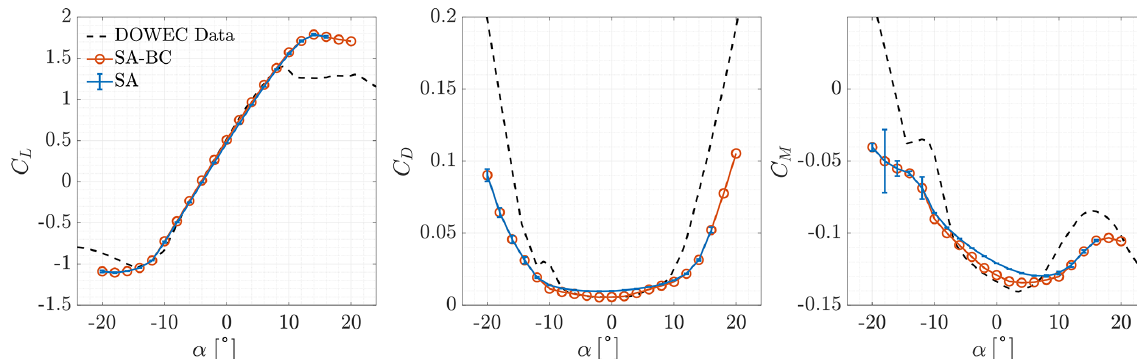
Figure 6. Aerodynamic coefficients of the DU21 airfoil.